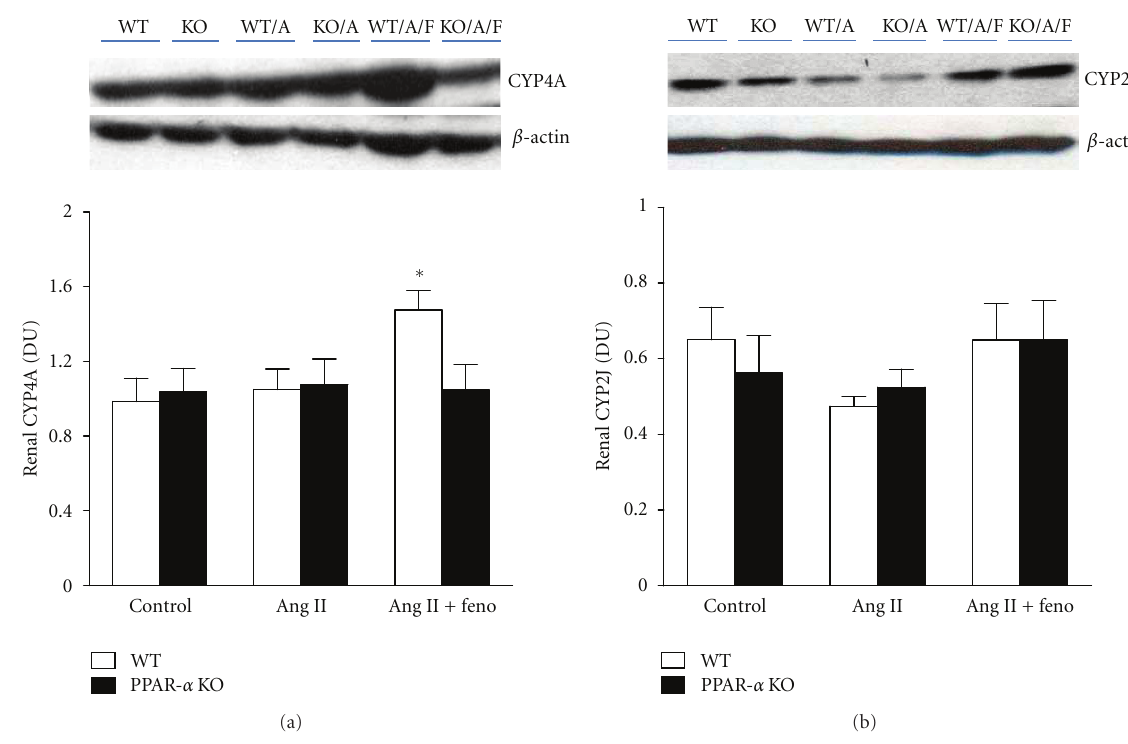
Figure 5: Renal CYP4A and CYP2J protein expression levels relative to β -actin in WT and PPAR α KO control, Ang II-infused and Ang II-infused + fenofibrate-treated mice. ∗ indicates a significant increase versus control WT mice ( n = 4 per